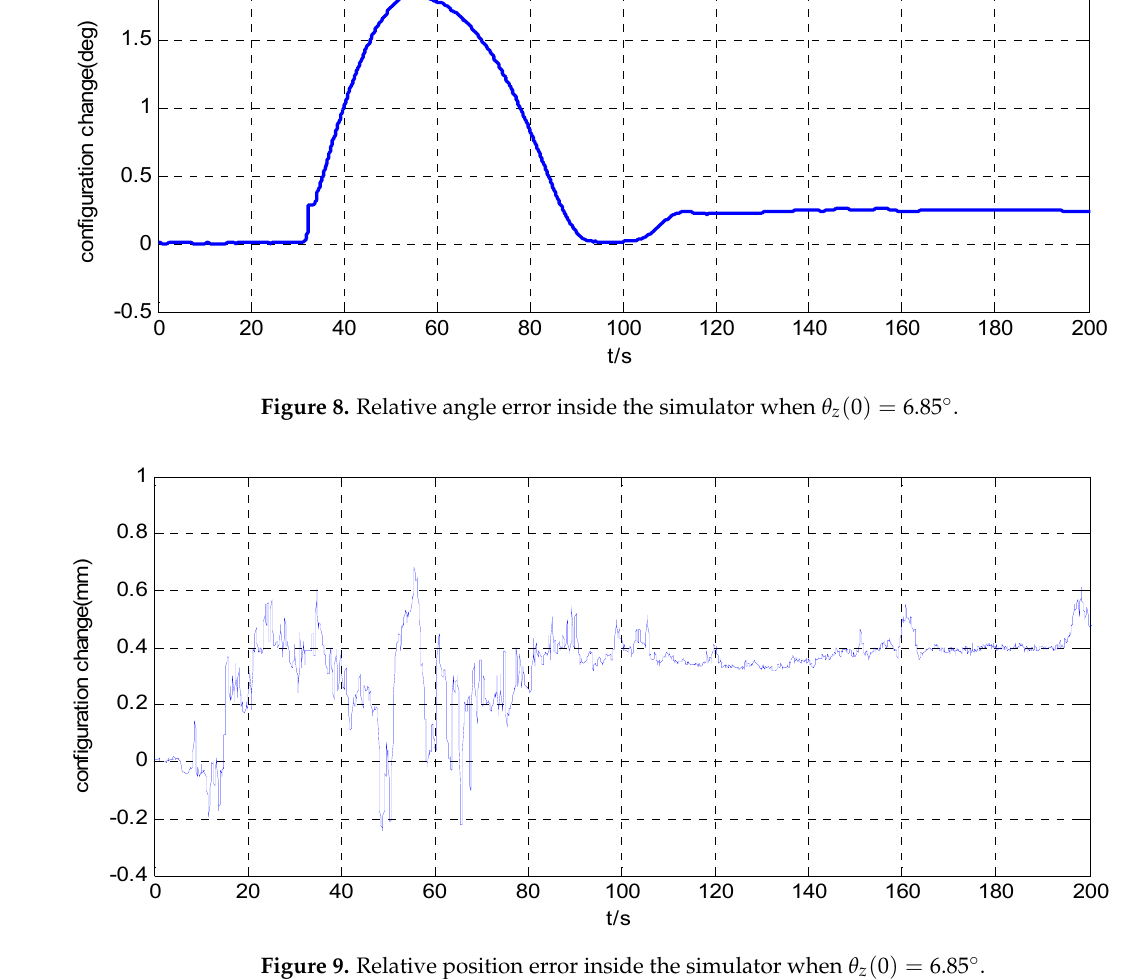
Figure 9. Relative position error inside the simulator when θ z ( 0 ) = 6.85 ◦ . In the second group of tests, the initial angle and angular velocity of the simulator are θ z ( 0 ) = 1.7 ◦ and ω z ( 0 ) = 0 ◦ /s, respectively. The desired angle and angular velocity of the simulator and parameters of the controller are the same as that of the first group of tests. The tests results are shown as Figures 10–13.